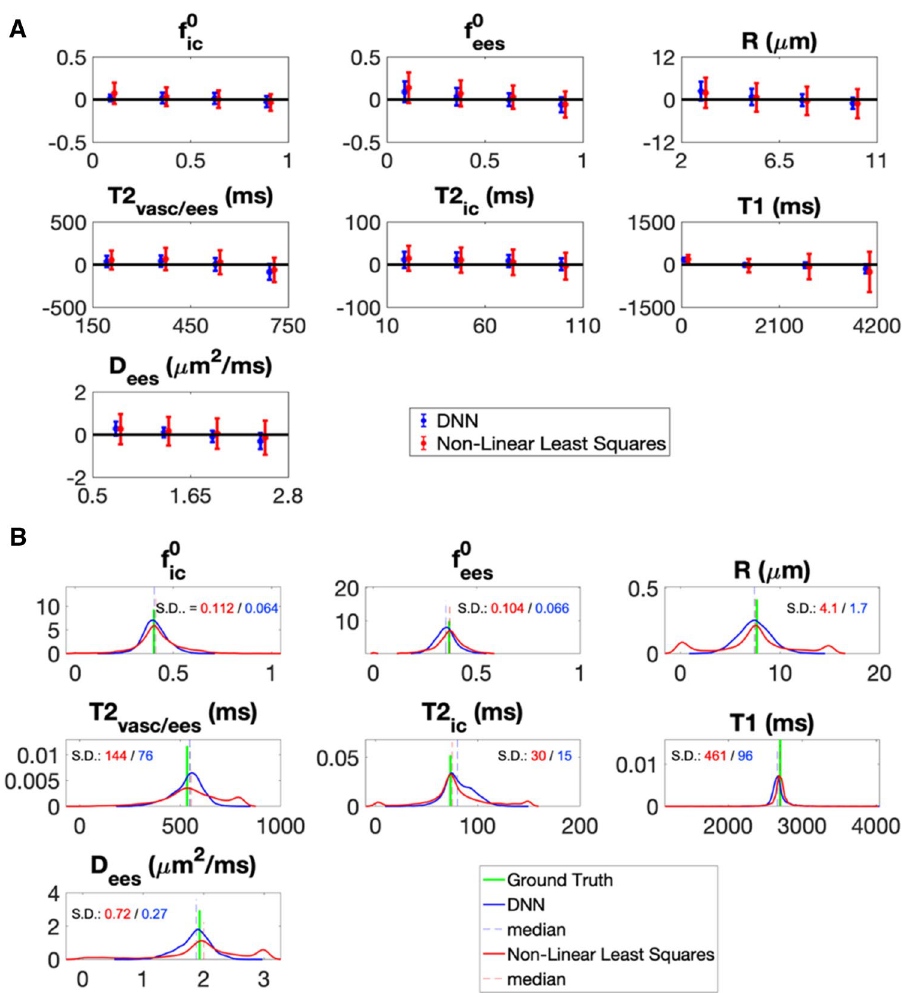
Figure 3. Accuracy and precision of model fitting. ( A ) The mean (data points) and variance (error bars) of the difference between the prediction for DNN or conventional non-linear least squares optimization and the ground truth values are plotted against the known ground truth from numerical simulations. The line at zero difference is also plotted as straight black line to aid appreciating the accuracy of the prediction from both methods (higher the accuracy, closer the mean difference to zero). The variance of the difference (error bars) is a good indicator of the precision of the estimation: smaller the variance, higher the precision. To make the results visually clear, data points for the non-linear least squares were purposely moved slighted to the right. ( B ) The probability density distribution of the estimates of the seven rVERDICT model parameters (S0 was fixed to 1) are plotted for seven ground truth values representative of PCa in TZ and PZ and 4096 different random realizations of the other parameters, for both DNN and conventional non-linear least squares optimisation. The wider the distribution, the less robust the estimation and the lower the precision due to degeneracy and/or spurious minima. We quantified the width of the distributions through their standard deviations (S.D.) reported in each plot with corresponding matching